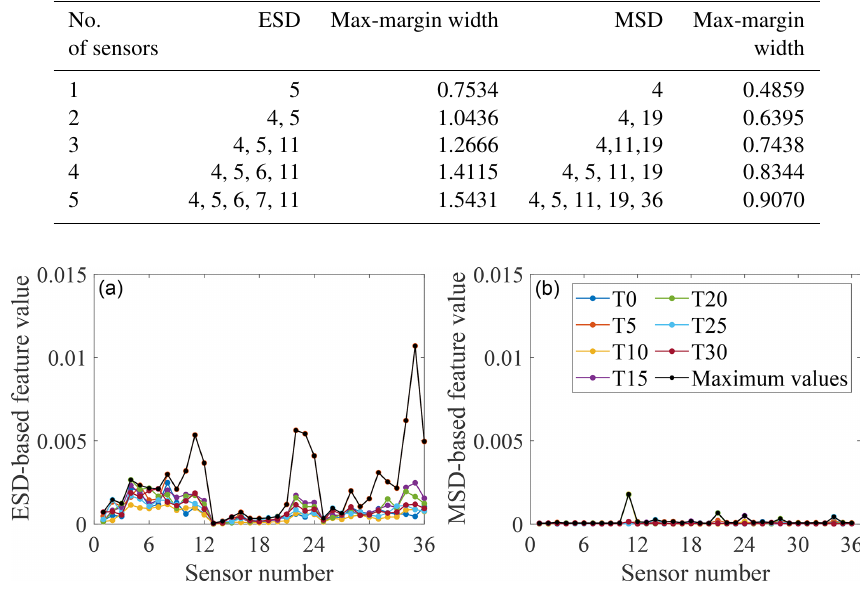
Figure 6. Feature-bagging results based on ESD (a) and MSD (b) for the normal condition. Seven controlled temperatures T 0– T 30 and the maximum value among the features for seven different temperatures are shown by colour markers. ESD-based features refer to features obtained by the normalised approach with temperature labels. MSD-based features refer to features obtained by the linear approach without temperature